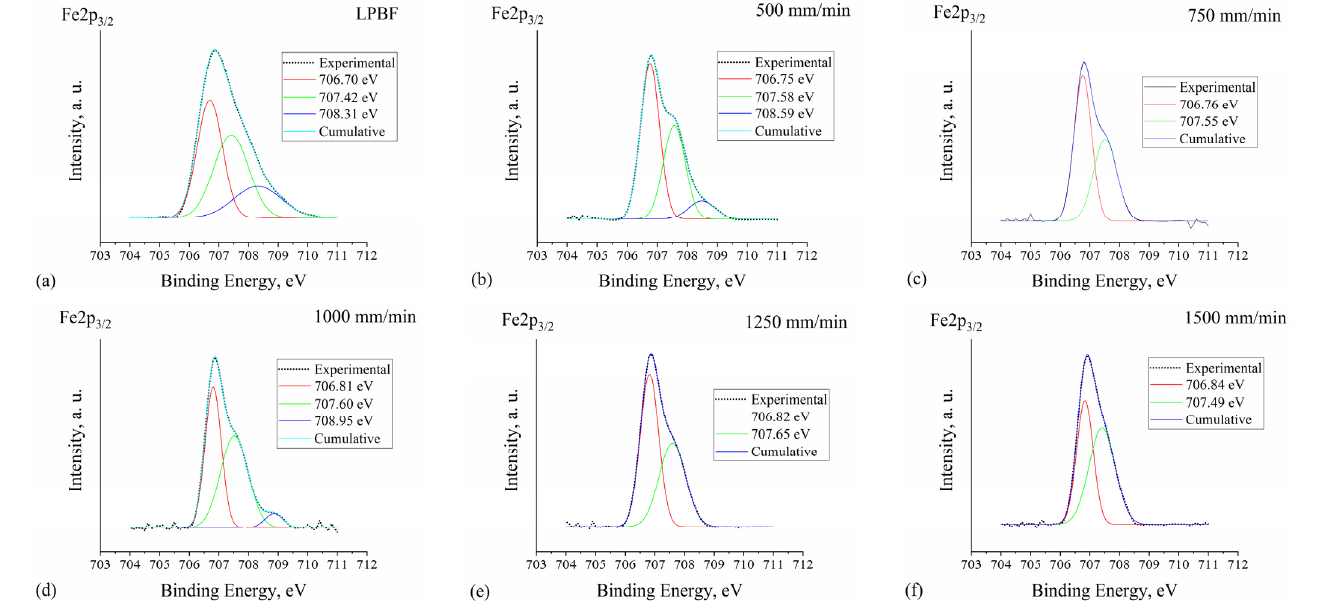
Figure 6. XPS spectra for Fe2p2/3 peaks with fitting curves for the LPBF specimen ( a ) and specimens laser boronized at 500 mm/min ( b ), 750 mm/min ( c ), 1000 mm/min ( d ), 1250 mm/min ( e ) and 1500 mm/min ( f ) laser operating speeds.